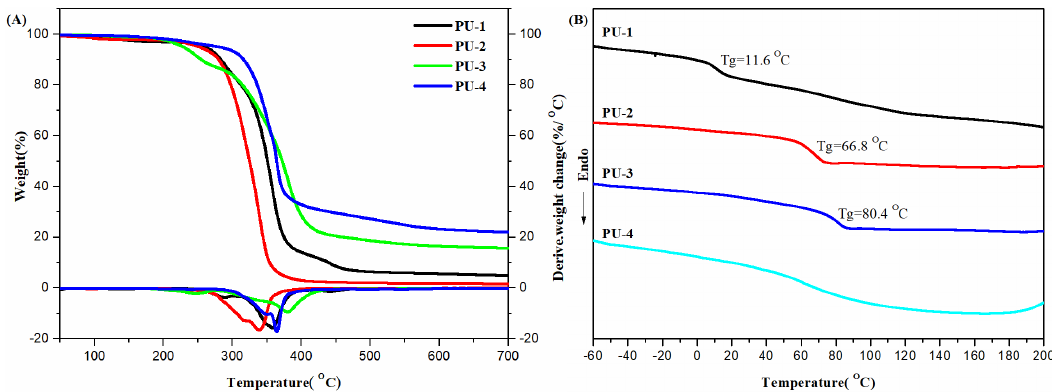
Figure 8. TGA curves ( A ) and DSC traces ( B ) of PUs.